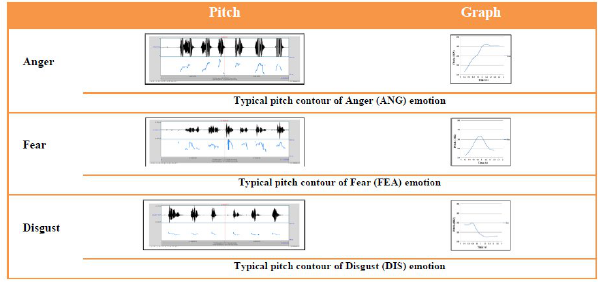
Fig. 10. Asian pitch contours for anger, fear and disgust.